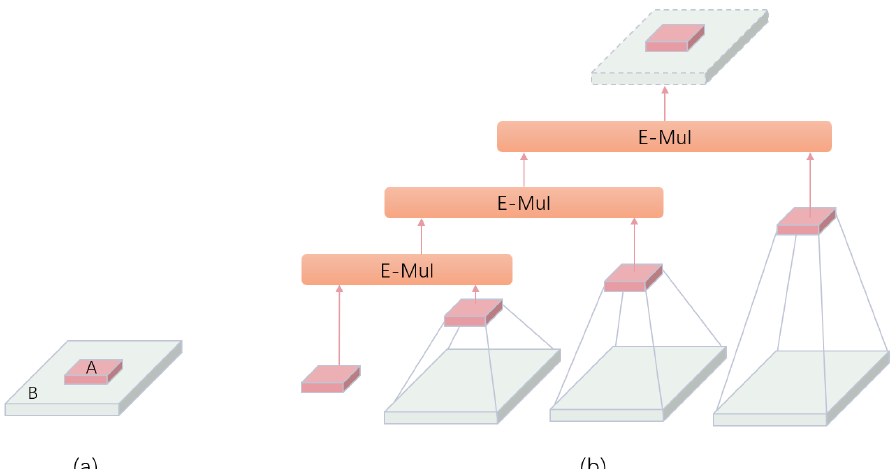
Figure 4. g n Conv module realizes spatial information interaction of any stage. ( a ) Object key feature (area A) and adjacent feature (area B). ( b ) Three-order information interaction is realized through element multiplication and recursive operation between the target research area and adjacent